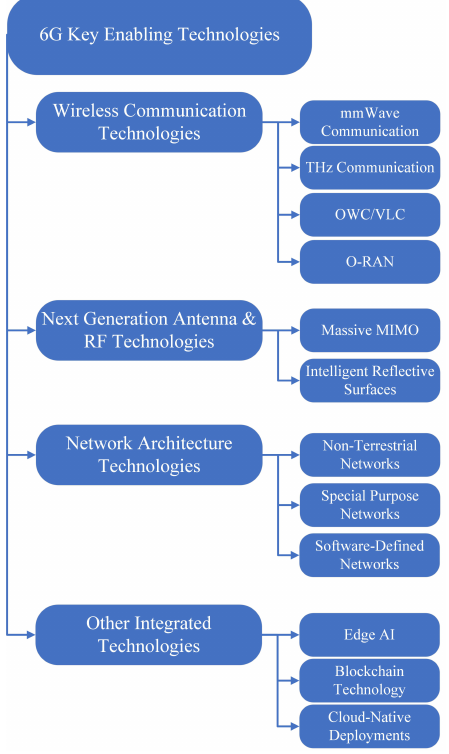
Figure 3. The key 6G enabling